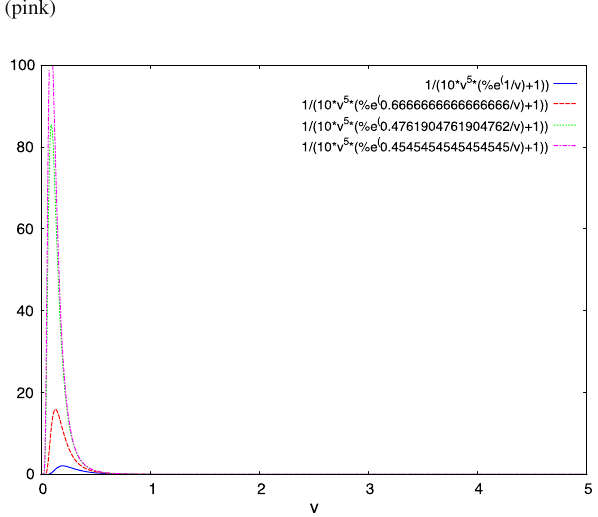
Fig. 5 P–V diagram of fidelity versus pressure. We address various temperatures of SAdS black holes. We indicate that fidelity does indeed represent thermodynamic volume. Here from bottom to top T = 1 (blue), T = 1